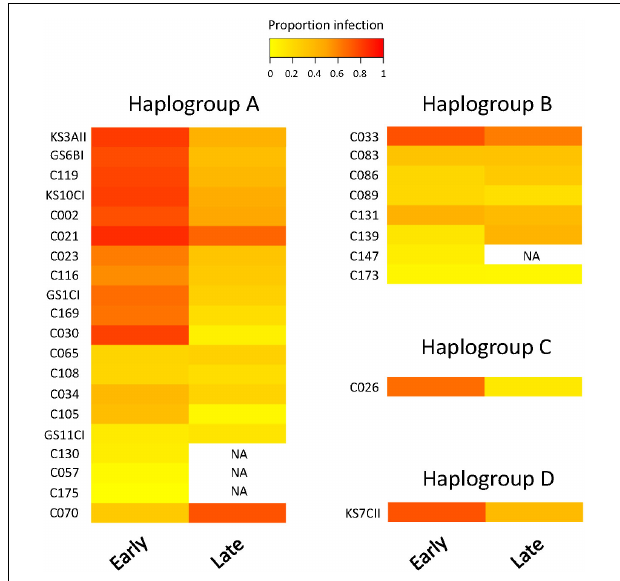
FIGURE 3 | Heatmap of resistance of 30 Paramecium caudatum strains (from 4 COI haplogroups) against the parasite Holospora undulata . Measurements of infection prevalence (proportion of infected host cells) were taken 5–7 days (“early”) and 2–3 weeks (“late”) post inoculation. Each row represents a different strain. The color gradient, from yellow to red, indicates increasing levels of infection prevalence, and thus decreasing resistance.